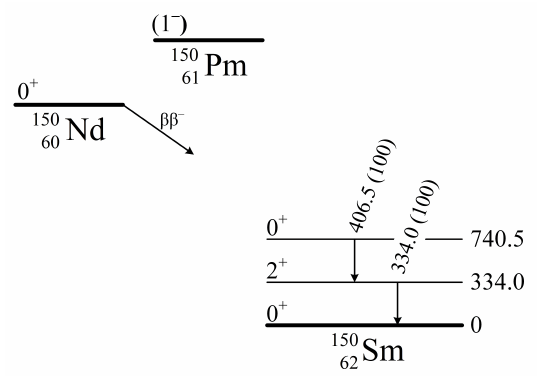
Figure 7. Simplified decay scheme of the 2 β − decay of 150 Nd to the 0 +